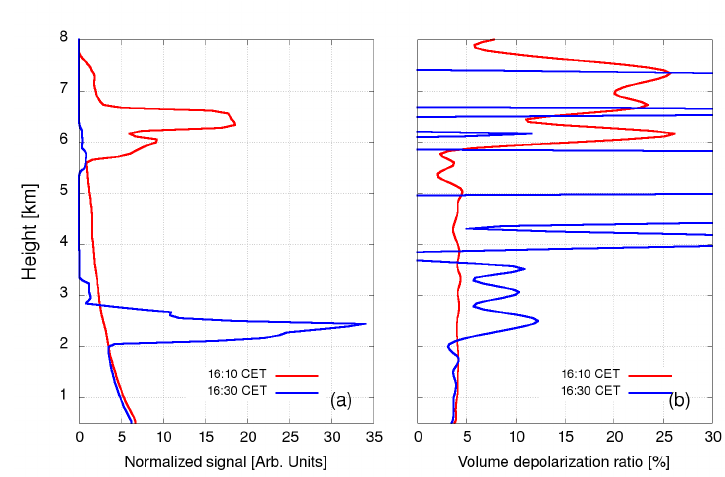
Figure 10. Normalized aerosol attenuated backscattering coefficients ( a ) and Volume Depolarization Ratio (VDR) ( b ) on 16 August 2017, at 16:10 CET and 16:30 CET. Peaks in the normalized attenuated backscattering coefficients determine the height of the cloud layers (6.5km and 2.5km). The corresponding VDR values are 0.25 and